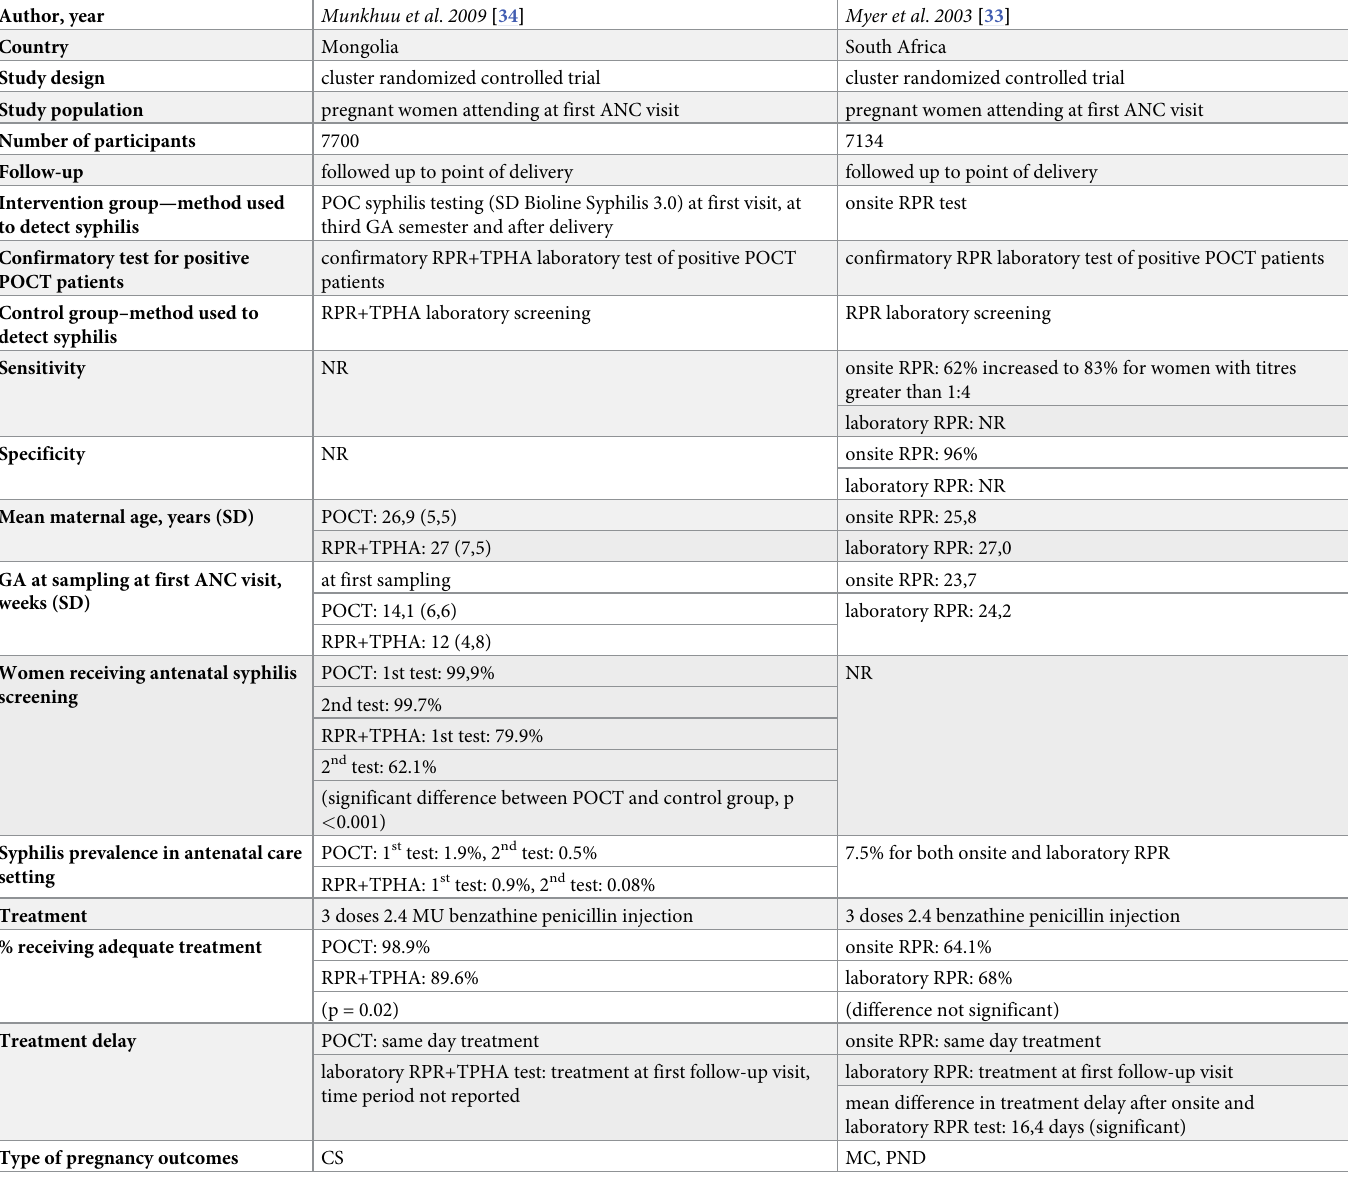
Table 1. Study characteristics in clinical